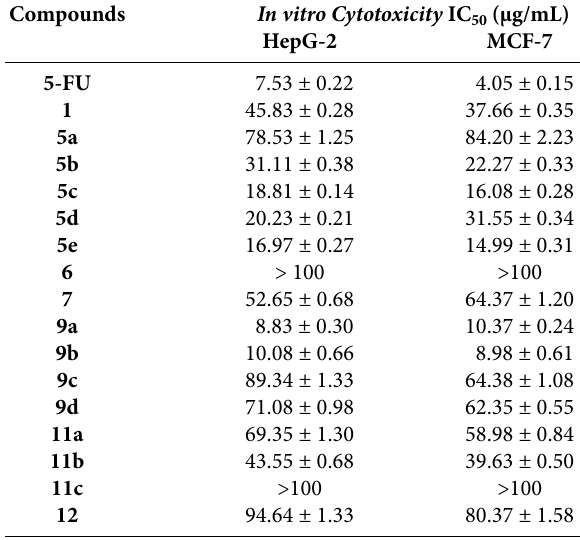
Table 2. Cytotoxic activity of the newly synthesized compounds Compounds In vitro Cytotoxicity IC 50